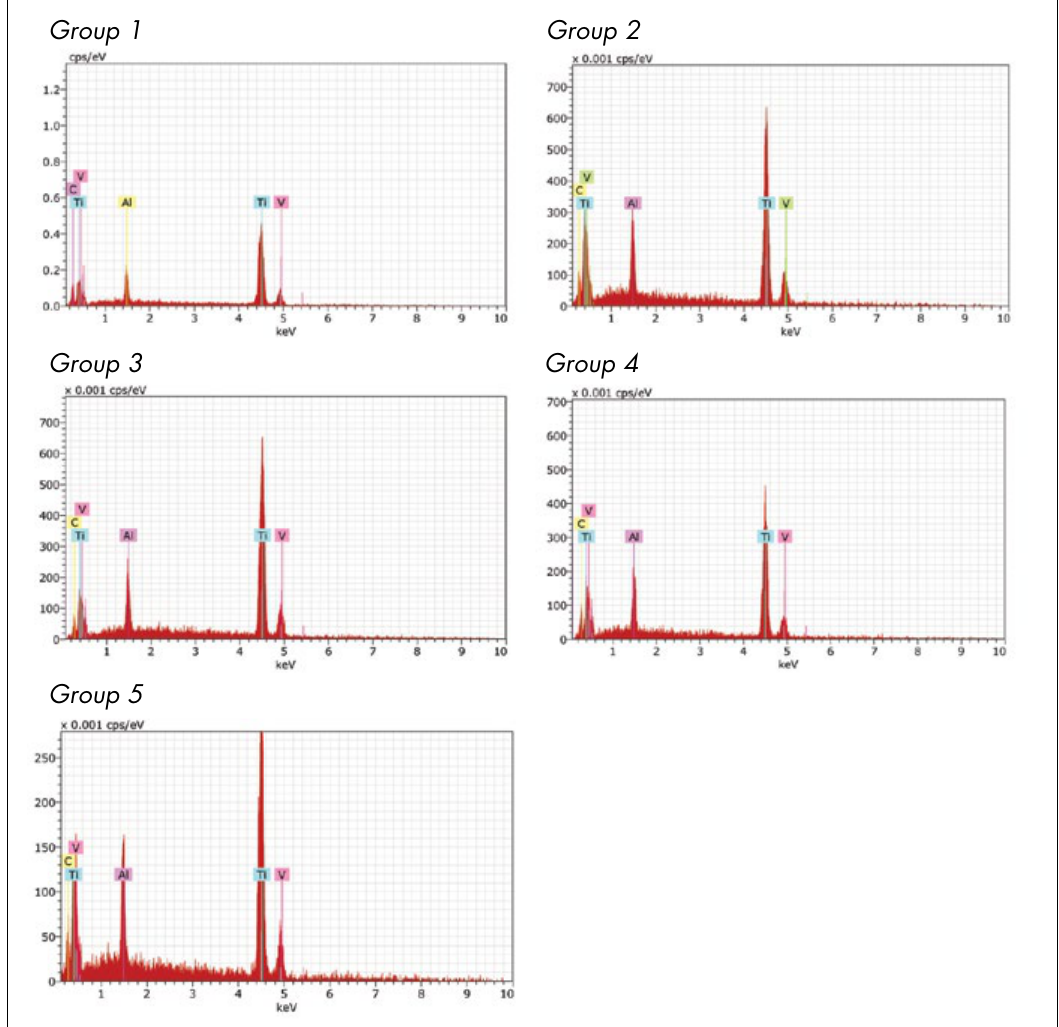
Figure 2. EDS spectra of elements present in the five groups of